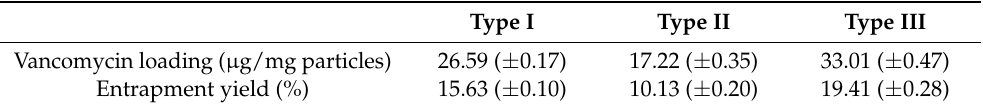
Table 1. Vancomycin loading and entrapment yield of different aerogels using superhydrophobic surfaces.